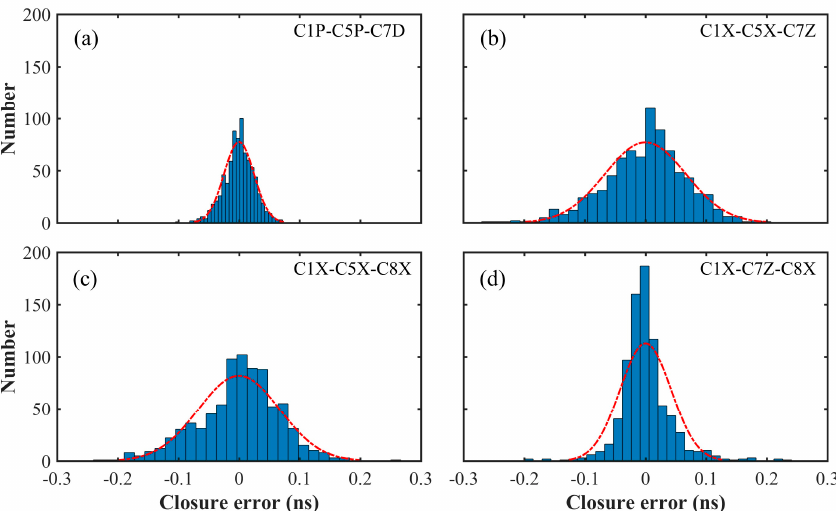
Figure 7. Distribution of BDS-3 satellites C1P-C5P-C7D ( a ), C1X-C5X-C7Z ( b ), C1X-C5X-C8X ( c ), and C1X-C7Z-C8X ( d ) closure errors. The red line denotes the fitted normal distribution curve.